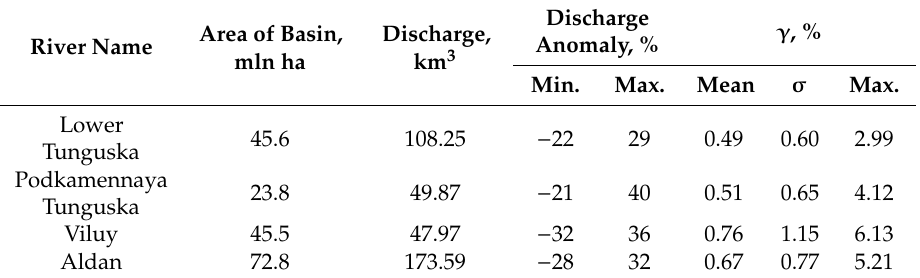
Table 1. The long-term discharge anomalies and relative burned area ( γ ).